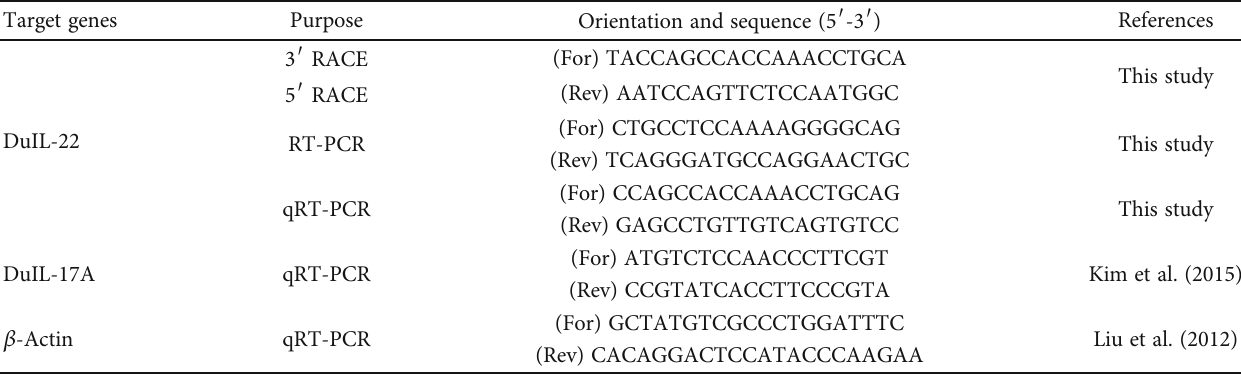
Table 1: Primers used for cloning and expression